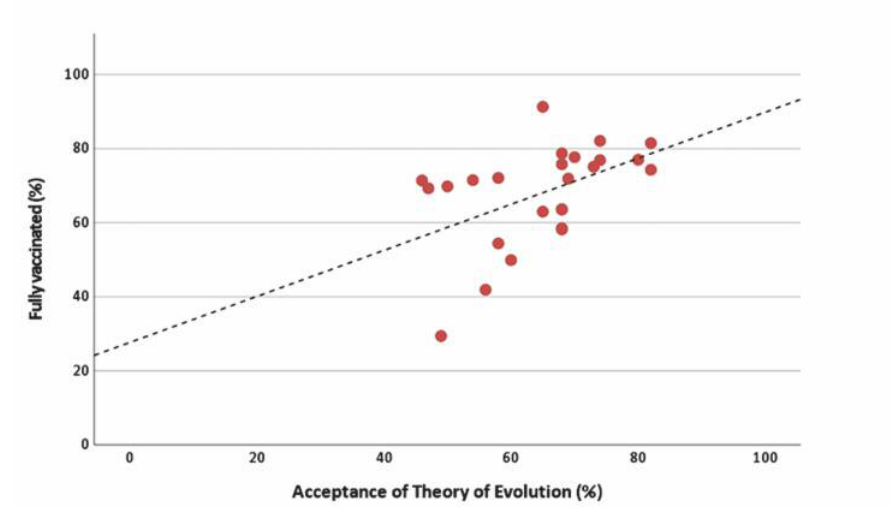
Figure 1. Linear regression of the acceptance of the theory of evolution (x-axis) and the rate of full vaccination in 25 countries of the European Union (y-axis). r = 0.478, p =